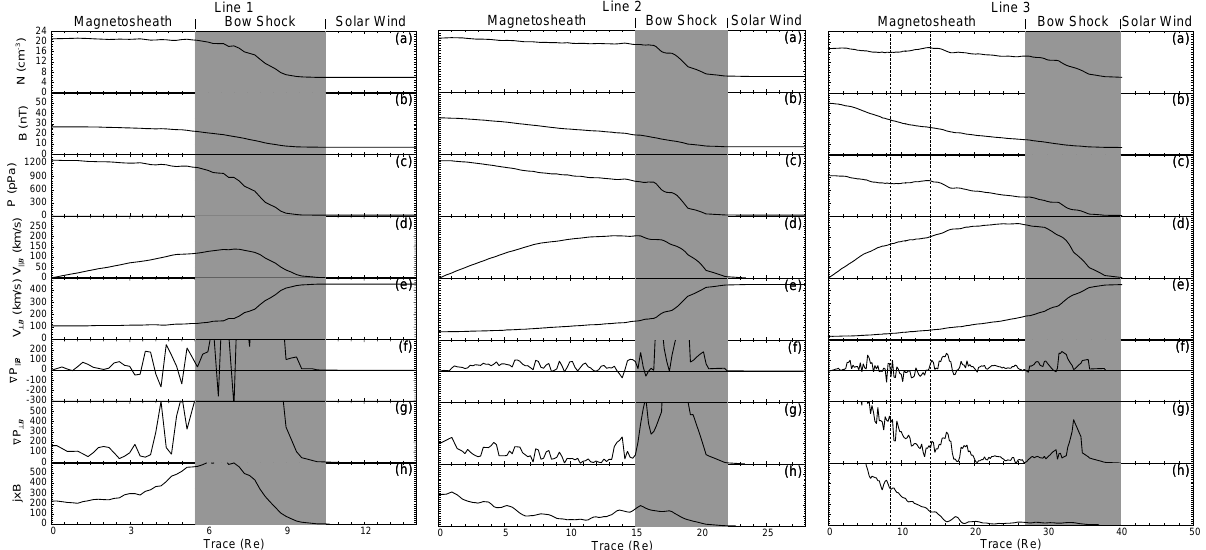
Fig. 14. Parameters along field lines 1–3 in the noon midnight meridian in Fig. 13. The horizontal axis is the distance along each magnetic field line northward from its crossing on the equatorial plane. In each panel, the shaded region is the bow shock, the region to the left of it is the magnetosheath, and the region to the right of it is the solar wind. From top to bottom are: the plasma density, the magnetic field magnitude, the plasma pressure, the flow velocity along and perpendicular to magnetic field, the pressure gradient force along and perpendicular to magnetic field, and the magnetic force (perpendicular to magnetic field). The unit of the forces in panels (f)–(h) is 10 − 19